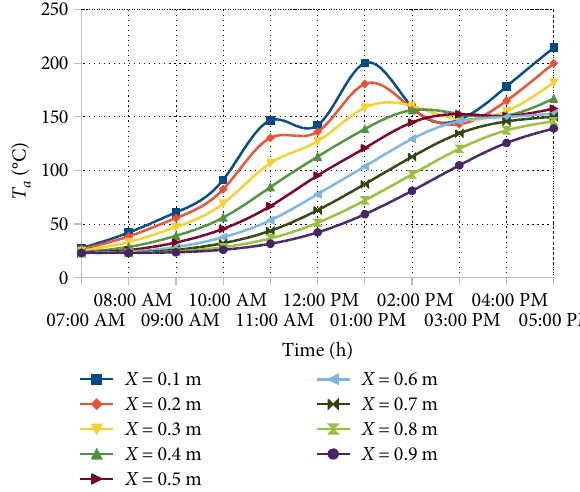
Figure 14: Energy stored versus charging h for both maximum and minimum direct normal